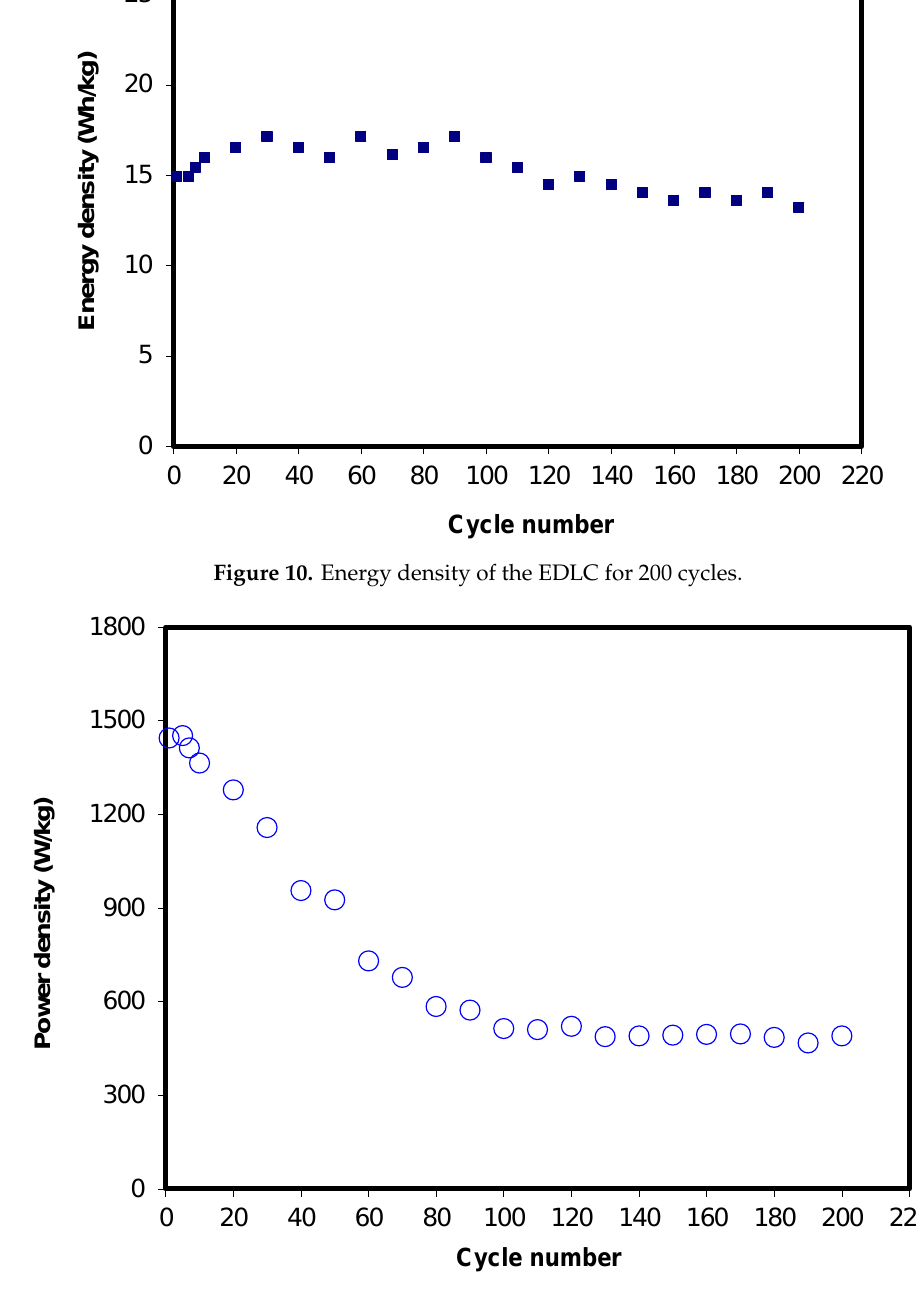
Figure 11. Power density of the EDLC for 200 cycles.